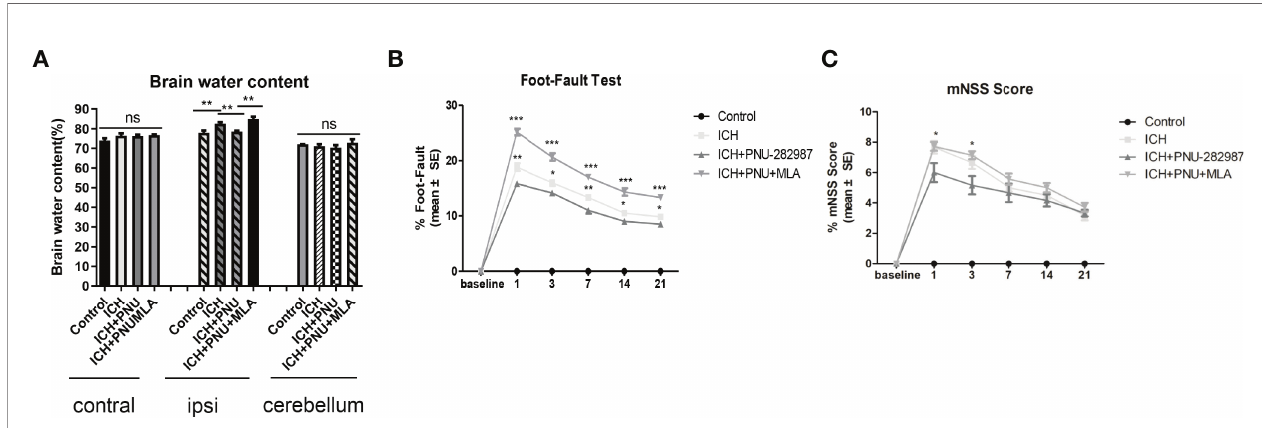
FIGURE 1 | Activating a 7nAChR decreased brain water content 3 days after ICH and improves neurological function in ICH mice. (A) PNU-282987 signi fi cantly reduces water content in the brain in the ipsilateral hemisphere. (B) Activating a 7nAChR decreases foot-fault test scores in ICH mice. (C) Activating a 7nAChR decreases mNSS scores in ICH mice. n= 5/group, the results are expressed as mean ± SE, *p < 0.05, **P < 0.01, ***P < 0.0001, ns means p >